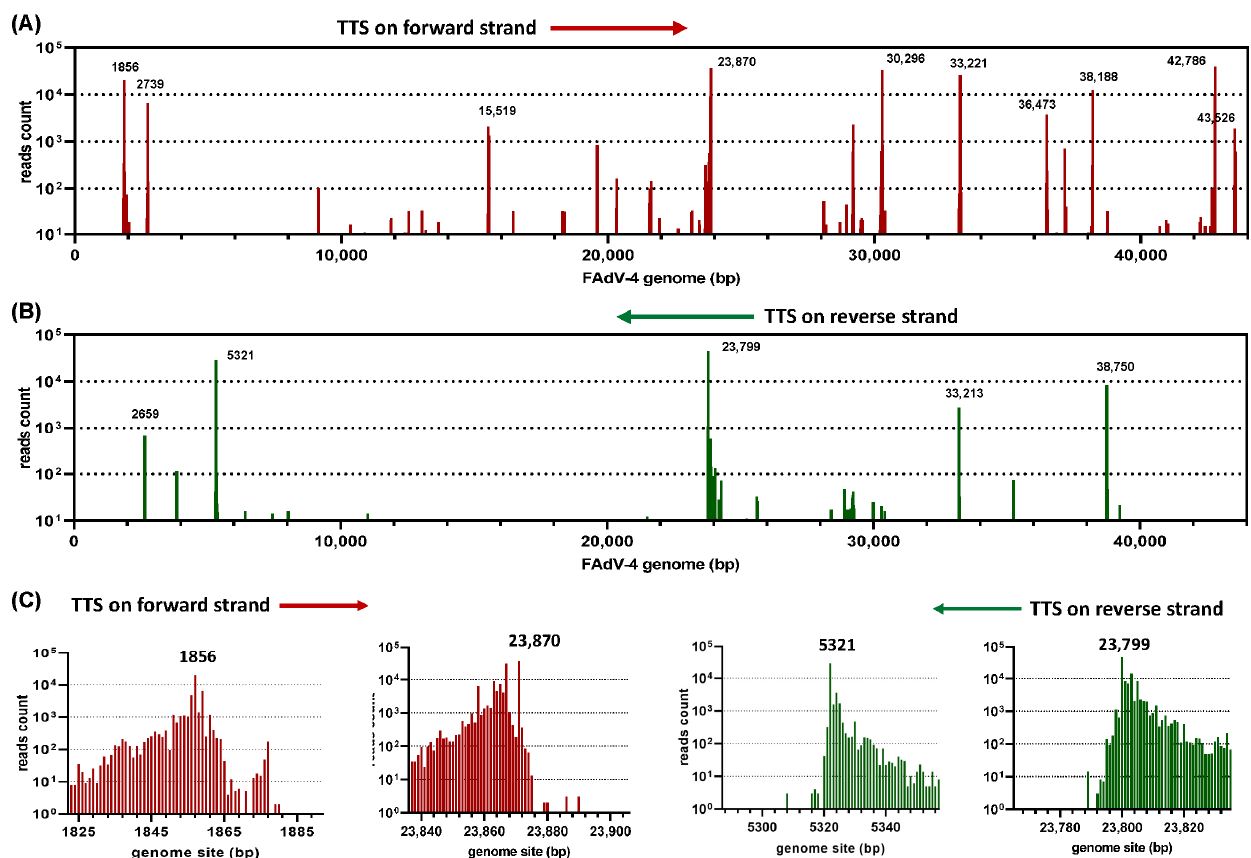
Figure 2. Determination of transcription termination sites (TTS) in the FAdV-4 genome. Viral full- length cDNA reads were aligned to the FAdV-4 genome (GenBank MG547384). The termination site of each read was extracted from the generated SAM file and expressed as the copy number of reads at each FAdV-4 genome position. ( A ) Read-termination sites on the forward strand of the whole virus genome. ( B ) Read-termination sites on the reverse strand of the whole virus genome. ( C ) The read termination sites in some representative regions were shown at single-nucleotide resolution.